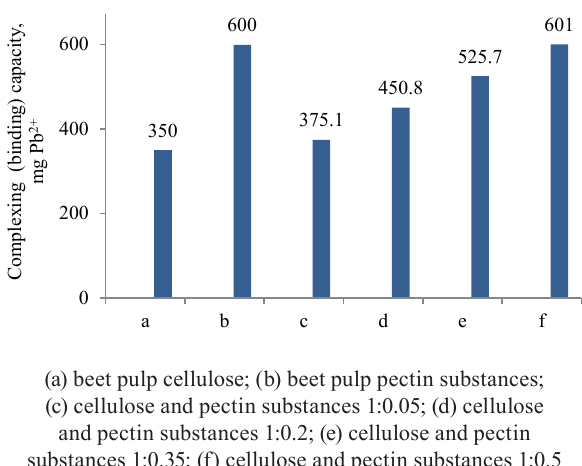
Figure 8 Microstructure of the dispersion system during interaction between the combined detoxicant and lead acetate solution Table 1 Process parameters for producing combined detoxicants from beet pulp Process stage and